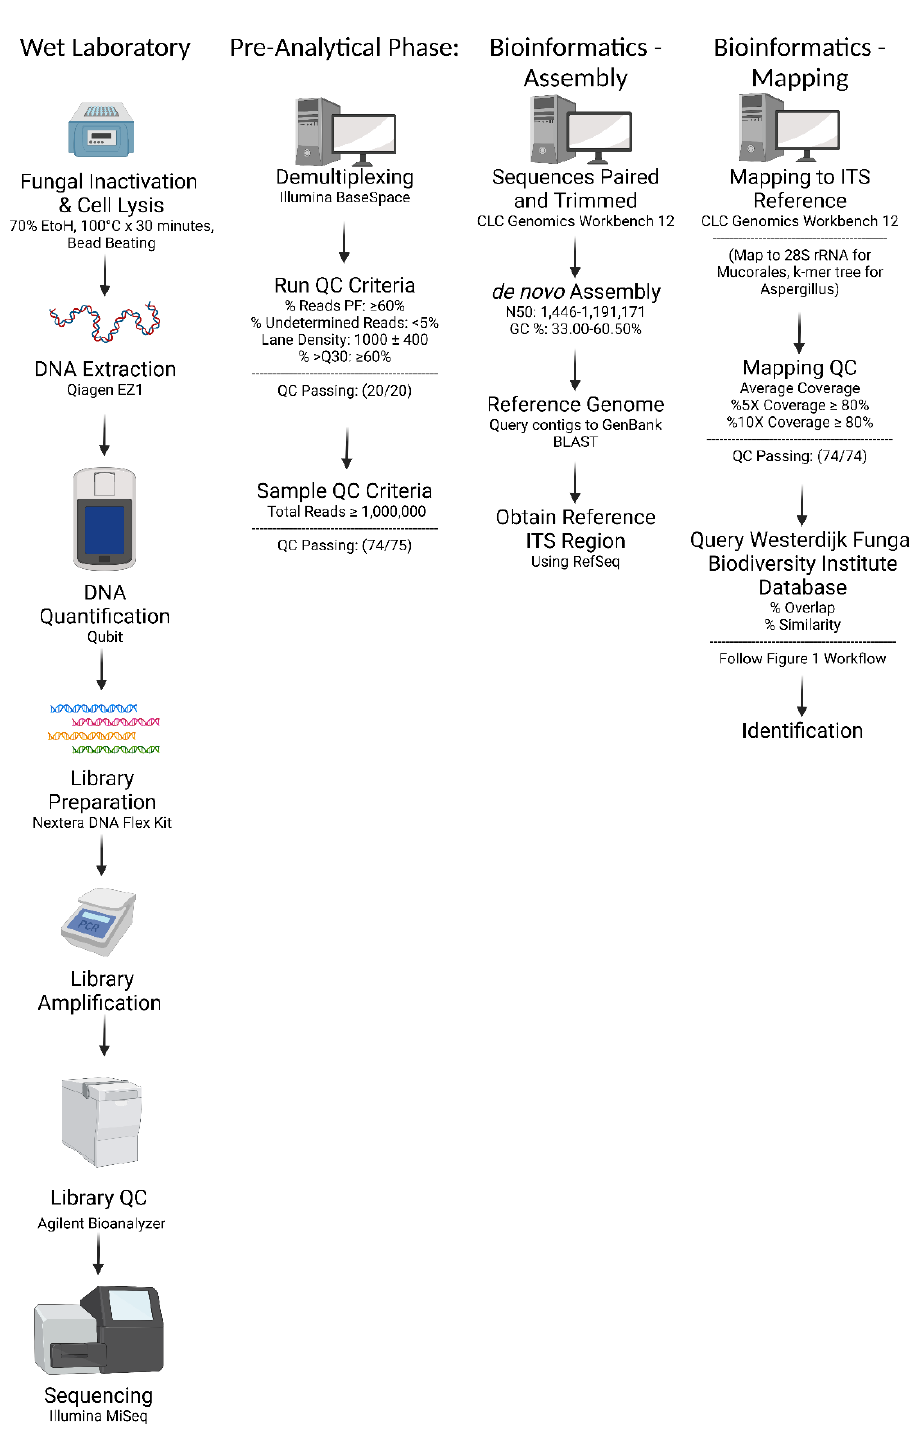
Figure 1. The Workflow of the WGS Test for Fungal Identification.